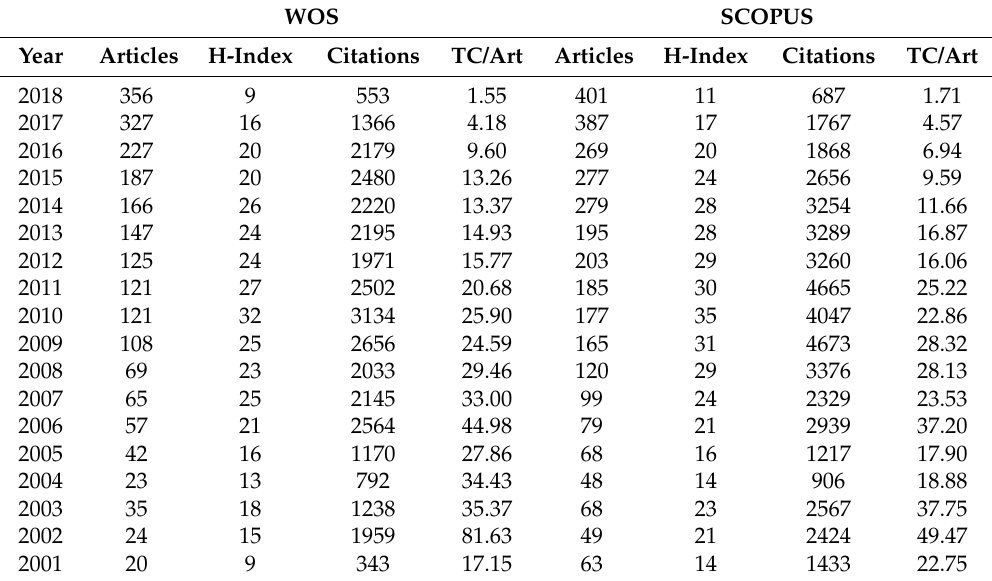
Annual distribution of the publication of Economy, Energy, and Environment (3E) scientific articles.